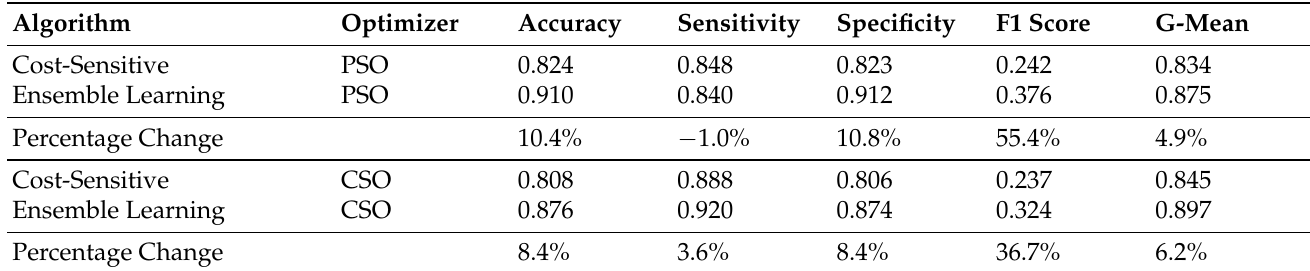
Table 13. A comparison between the results of the evaluation metrics from the cost-sensitive MHOANN and those from the cost-sensitive MHOANN within the majority voting ensemble learning system using the dataset of Taiwanese companies.